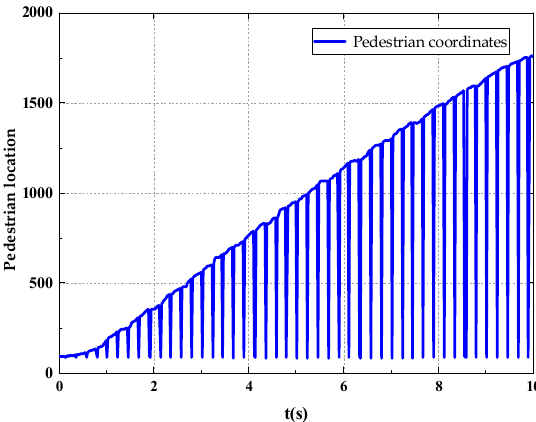
Figure 9. Pedestrian Coordinate Chart.